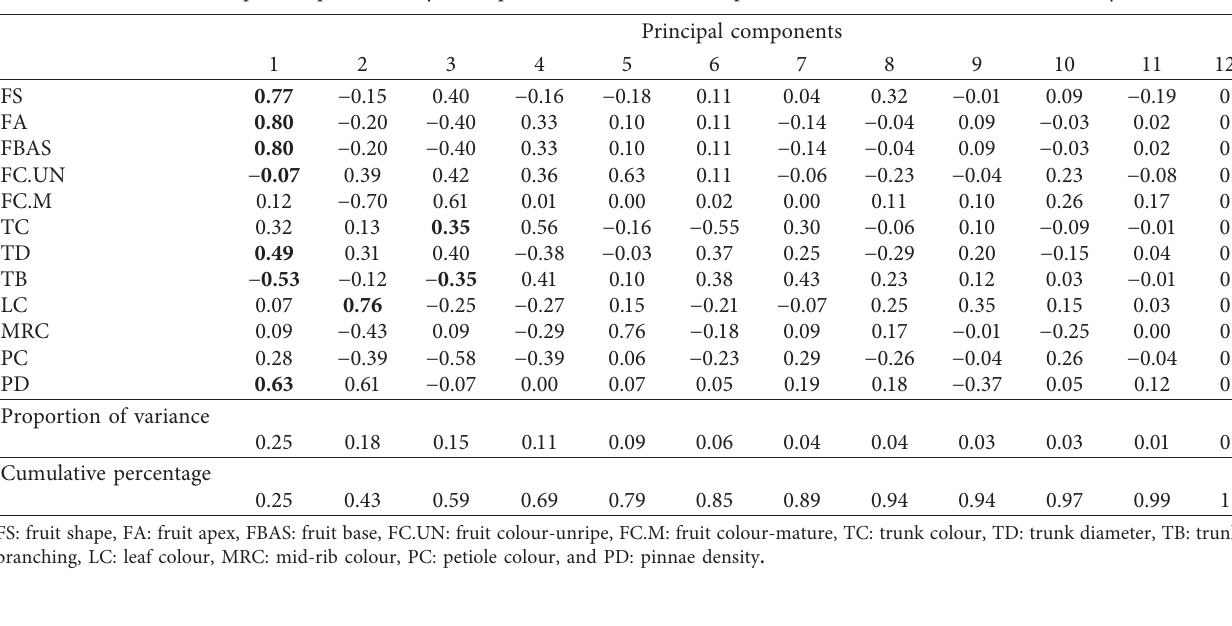
Table 7: Principal component analysis of qualitative traits of doum palm in arid and semi-arid lands of Kenya.